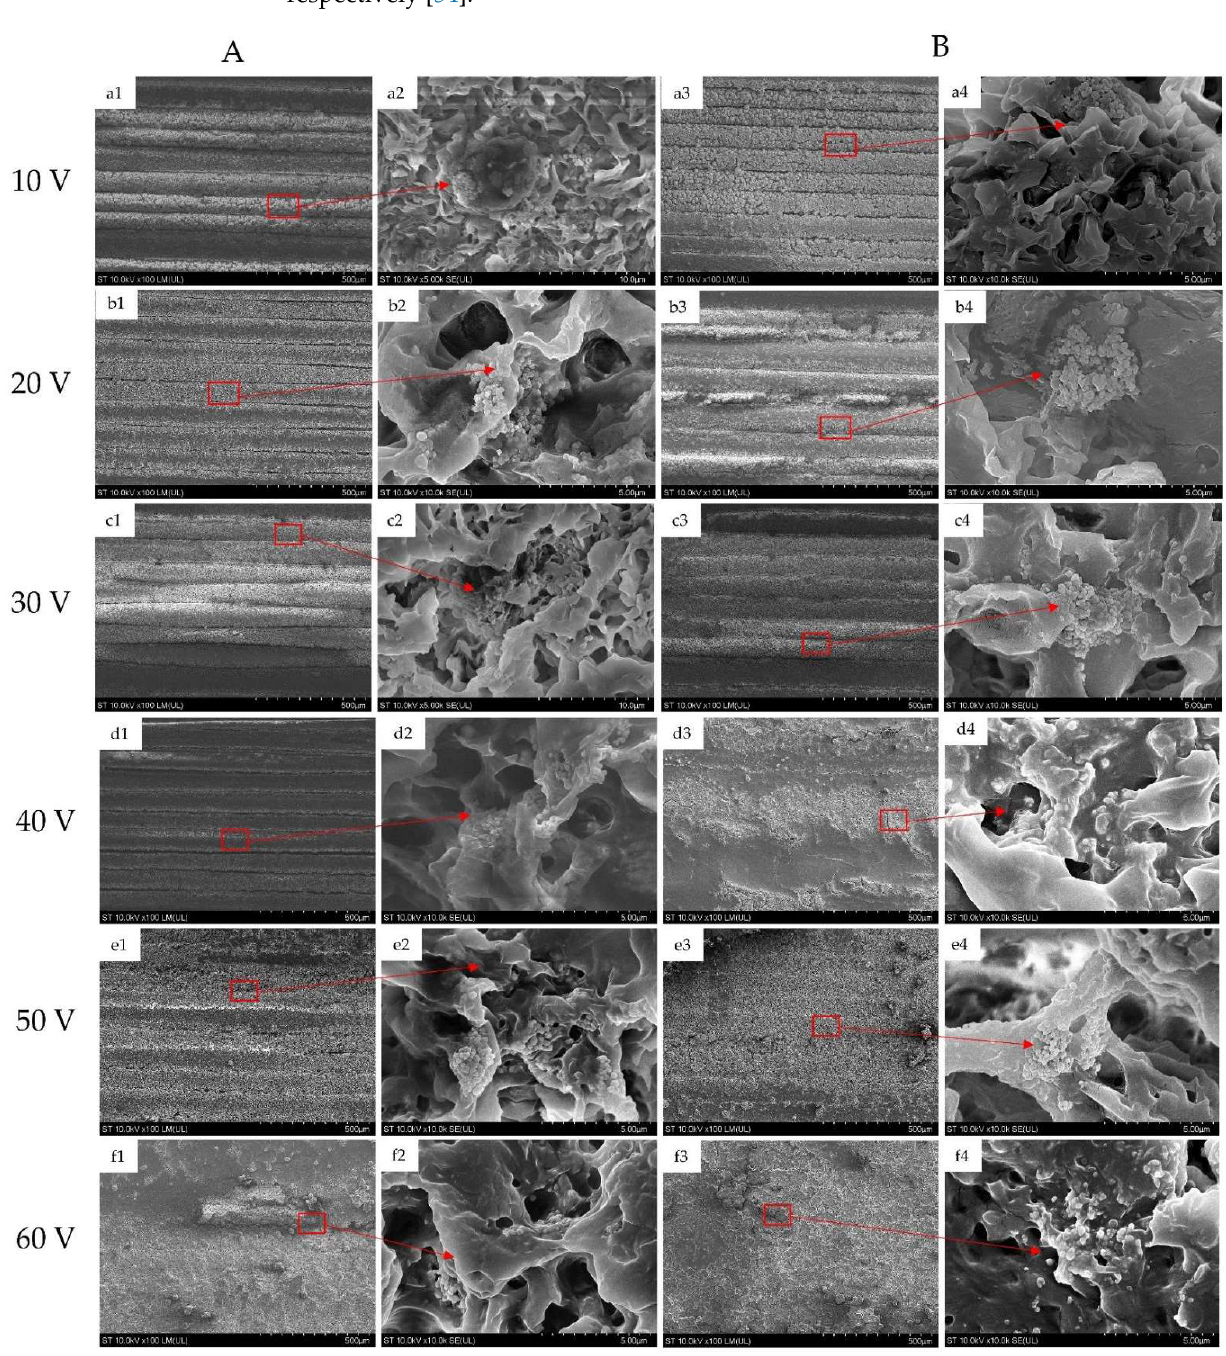
Figure 6. SEM images of the bacterial biofilms alongside ( A ) at 10 V (( a1 )—×100; ( a2 )—×10,000); 20